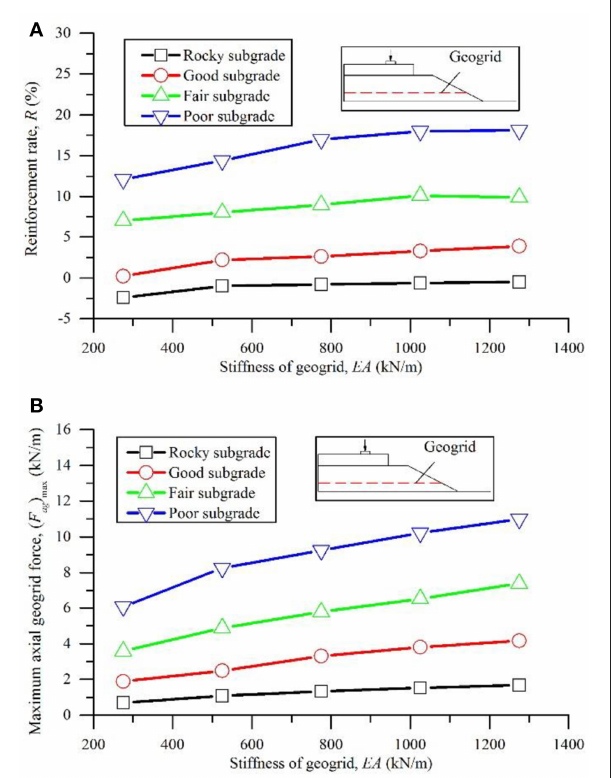
FIGURE 4 | Reinforcement rate and maximum axial force in geogrids with respect to the factor of geogrid stiffness over different subgrades (Case 2): (A) reinforcement rate; (B) maximum axial geogrid